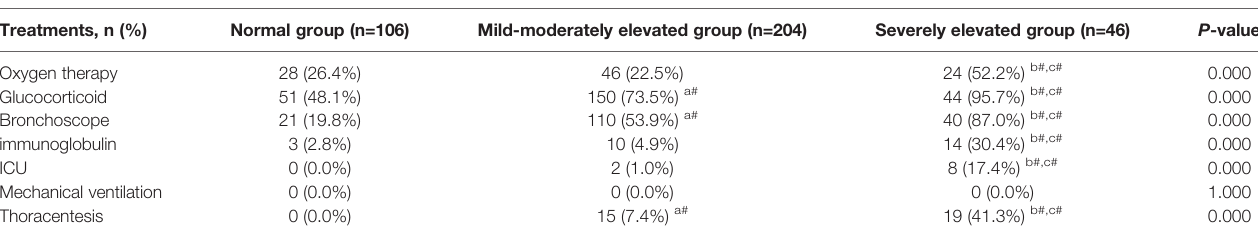
TABLE 4 | Treatments of patients with MPP. Treatments, n (%)